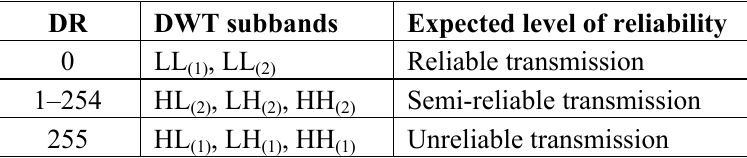
Table 1. Values for the Data